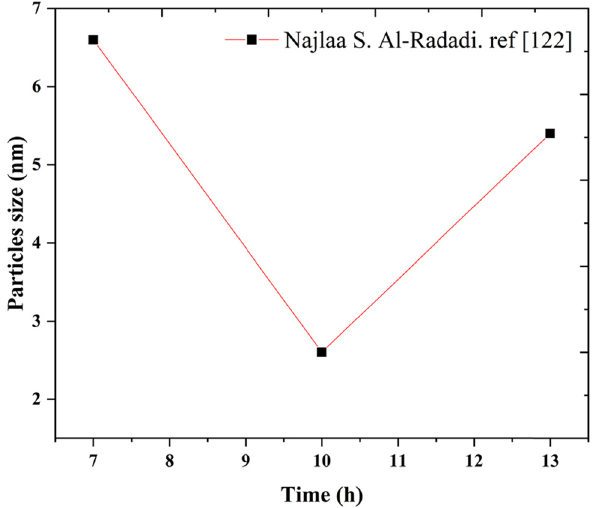
Figure 5: The e ff ect of reaction time on the particle size variation of Pt NPs at room temperature, adapted from ref. [ 122 ]